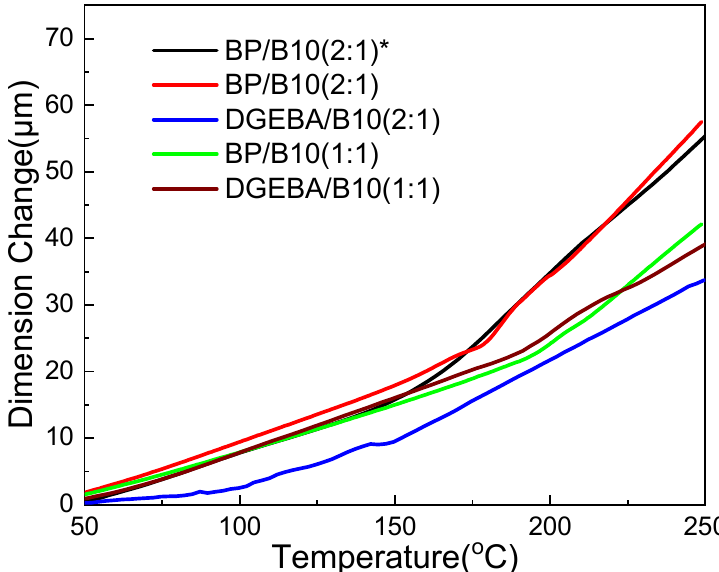
Figure 6. Thermal mechanical analysis of epoxy (*: anisotropic).